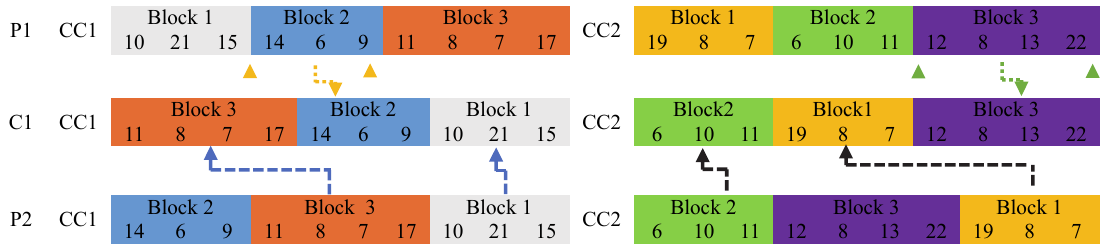
Fig. 3. Illustration of crossover